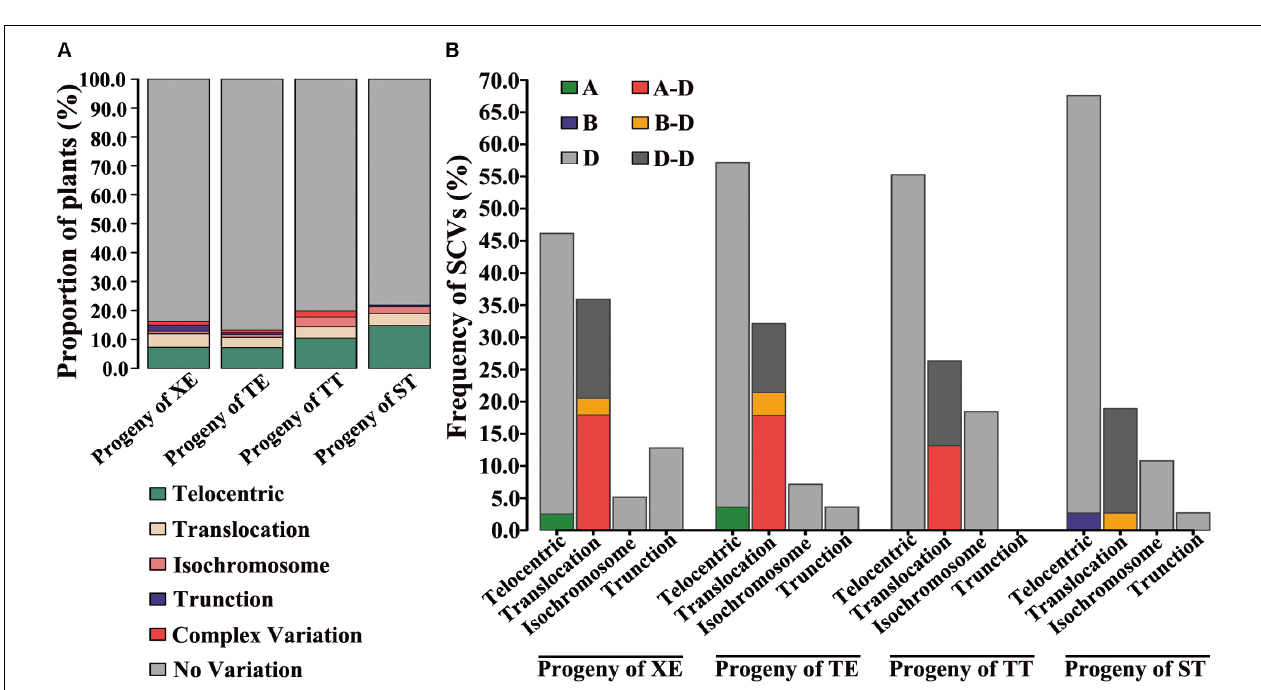
FIGURE 4 | SCVs in the immediate progeny swarms of each of the four pentaploid wheat lines. (A) Relative proportions of plants with the variable types of SCVs in the four immediate progeny swarms of the pentaploid wheat lines. (B) Relative proportions of chromosomes of each subgenome with SCVs in the four immediate progeny swarms of the pentaploid wheat